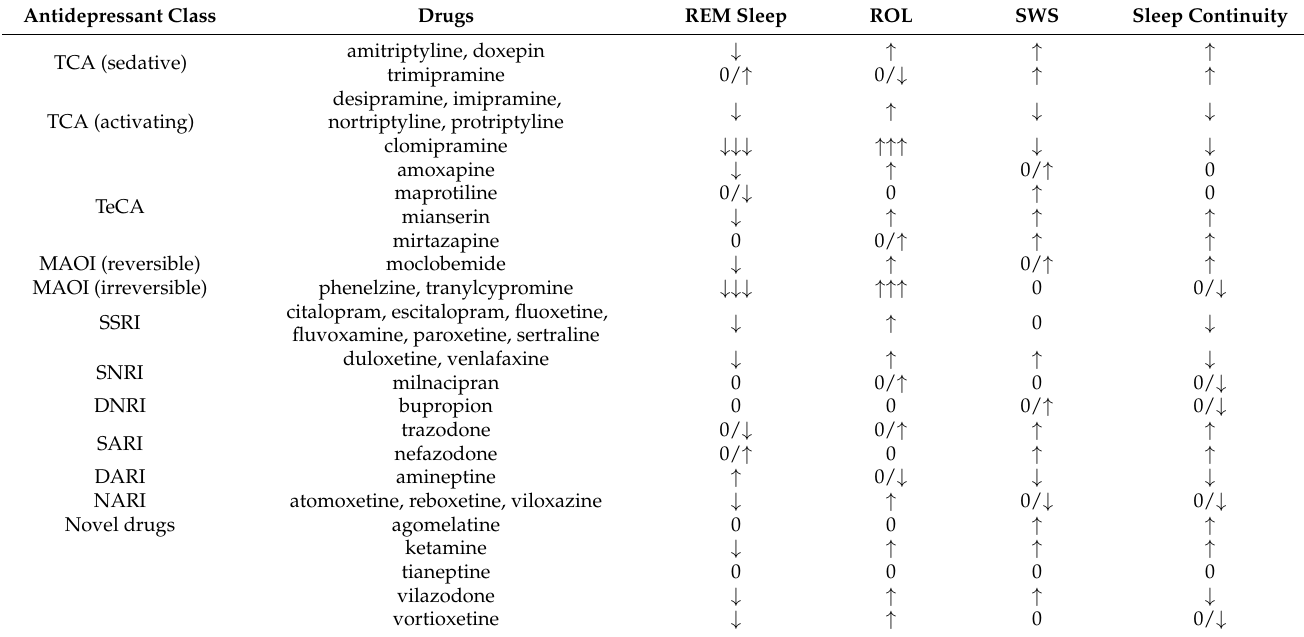
Table 3. Summary of chronic effects of antidepressants on human